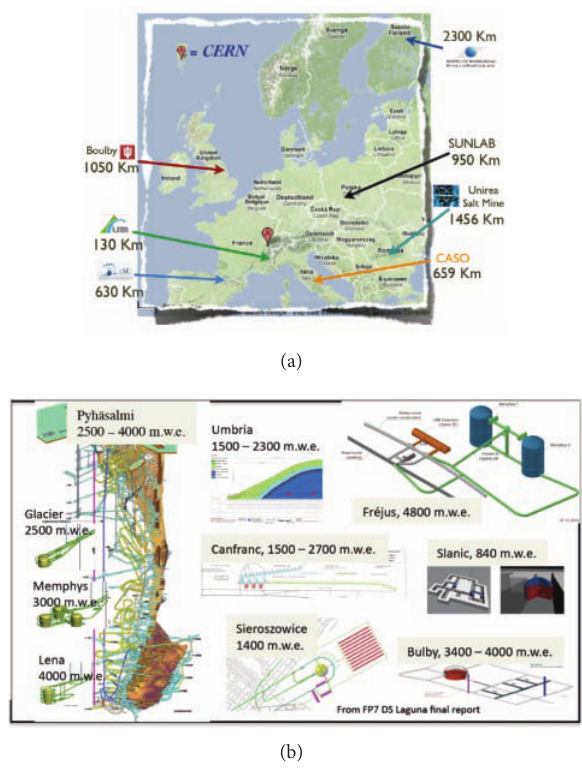
Figure 23: (a) Map of the seven possible underground sites in Europe. (b) Exemplary layouts studied in LAGUNA DS for each